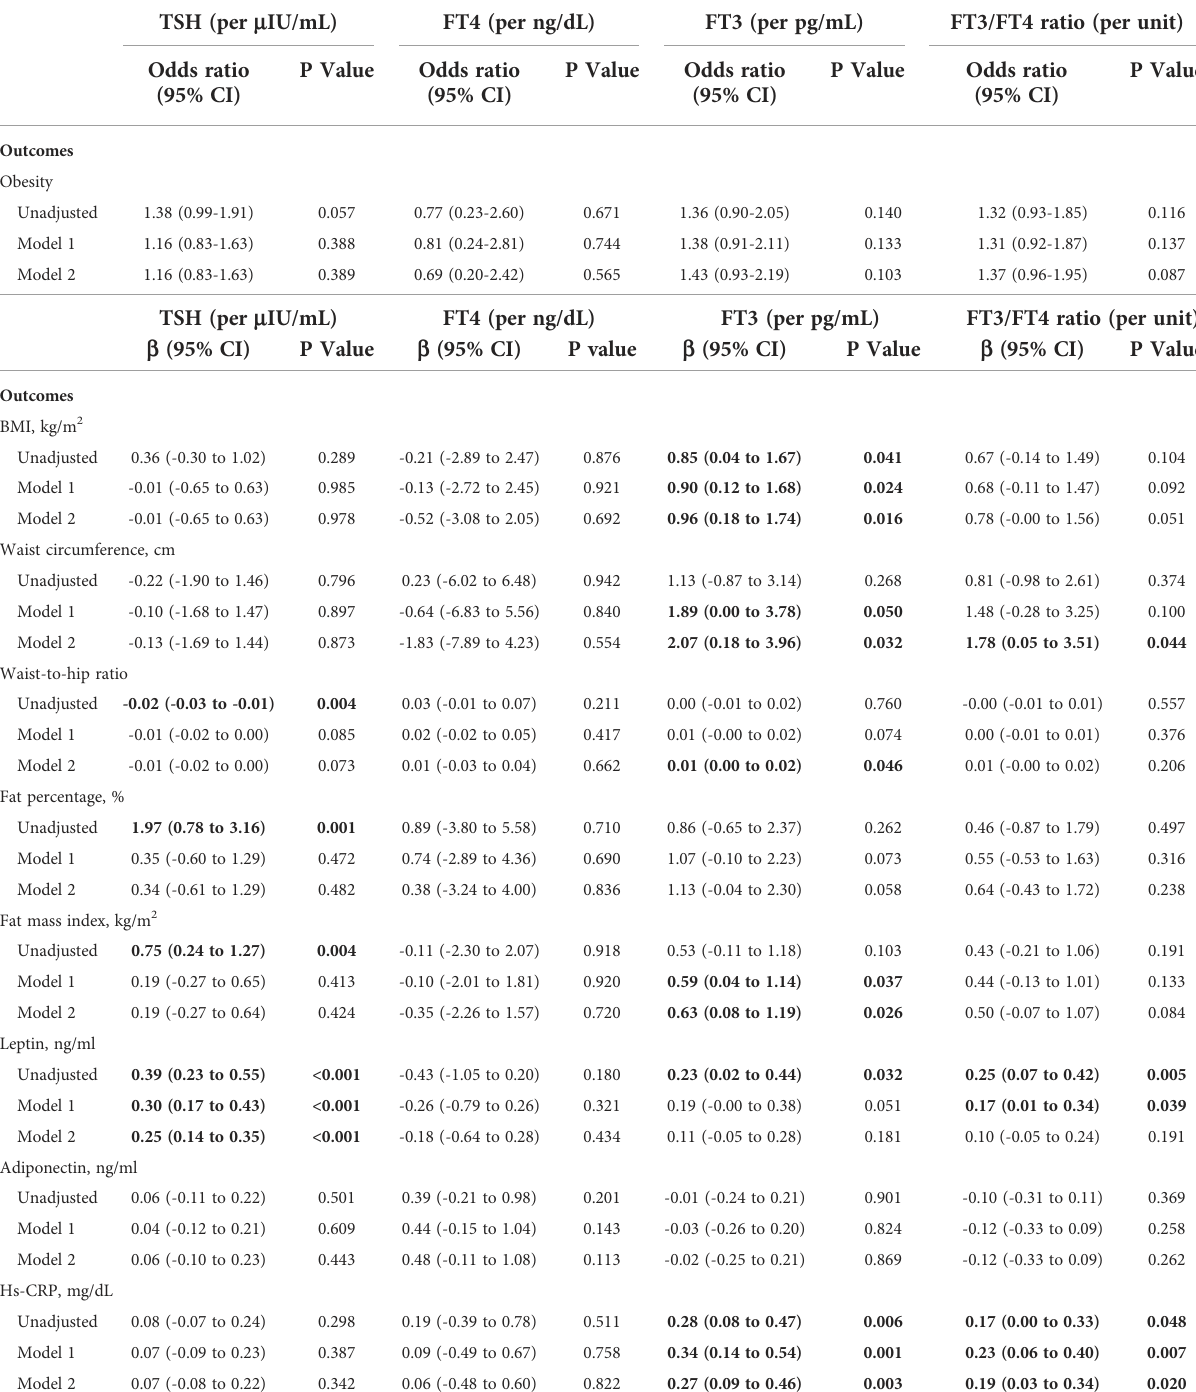
TABLE 2 Association of thyroid function with obesity, anthropometric parameters, plasma adipokines and high-sensitivity C-reactive